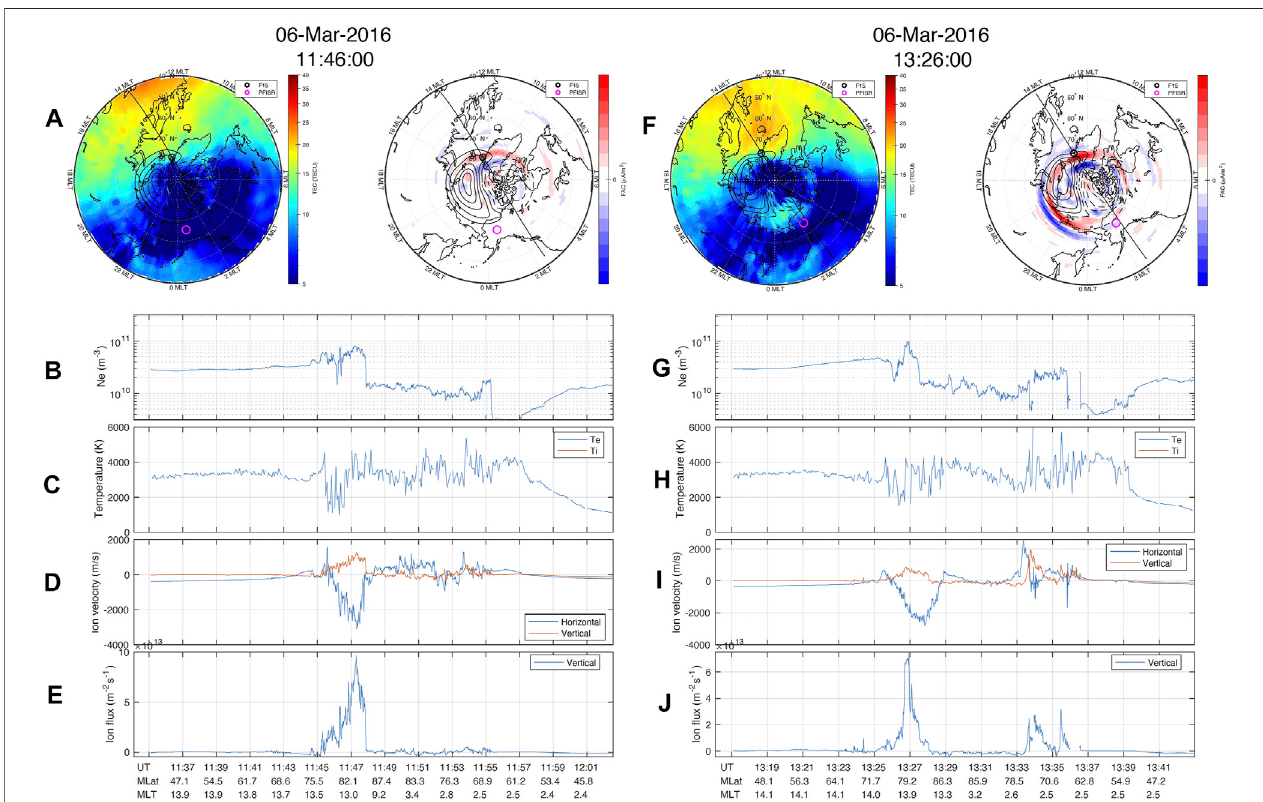
FIGURE 6 | Two periods of DMSP F15 measurements during the large negative IMF By period, i.e., 11:35 – 12:01 UT (A – E) and 13:17 – 13:41 UT (F – J) . Two selected TEC/convection/FAC polar viewplots at 11:46 UT and 13:26 UT arealso shown at thetop (A , F) .From top tobottom, theDMSP observations include plasma density, electron temperature, horizontal (blue) and vertical drift (red), and the vertical fl ux, which is the product of plasma density and vertical fl ow. The trajectory of the DMSP satellite during this period is shown in the polar view